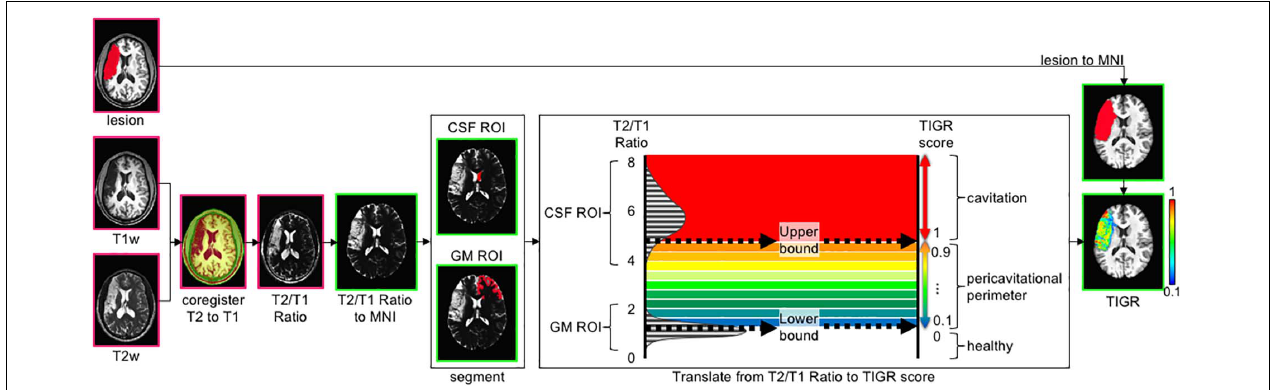
FIGURE 1 | The tissue integrity gradation via T2w T1w ratio (TIGR) analysis pipeline. The user input includes a T1w image, T2w image, and a binary lesion mask. After co-registering the T2w and T1w images, the T2w/T1w ratio is computed on a voxel-wise basis and transformed into MNI template space. The right hemisphere anterior lateral ventricle is segmented to represent the cerebrospinal fluid (CSF) region of interest (ROI), and the anterior contralateral gray matter (GM) ribbon is segmented to represent the GM ROI. The histogram of T2w/T1w signal distribution is plotted for each individual subject and then thresholded as described in the